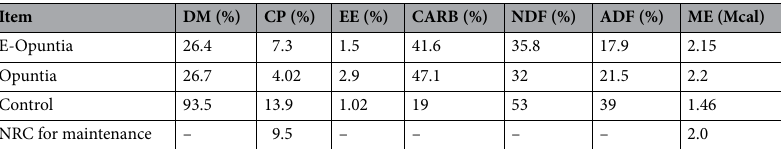
Table 5. Composition (DM basis) of the diets offered during adaptation, breeding and last trimester of gestation, compared with the requirements for a 50-kg ewe 52 . DM dry matter, CP crude protein, EE ether extract, CARB carbohydrates, NDF neutral detergent fiber, ADF acid detergent fiber, ME metabolizable energy, NRC nutritional requirements of small ruminants 52